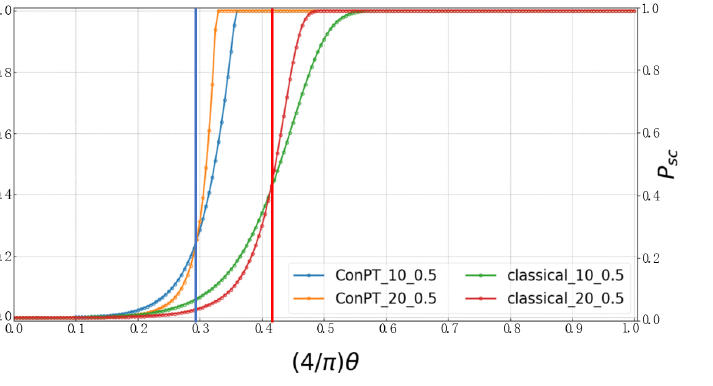
Figure 9. Comparison between classical percolation and ConPT: the percolation threshold using classical method (red vertical line) and the percolation threshold using ConPT method (blue vertical line) can be obtained by Monte Carlo simulation.